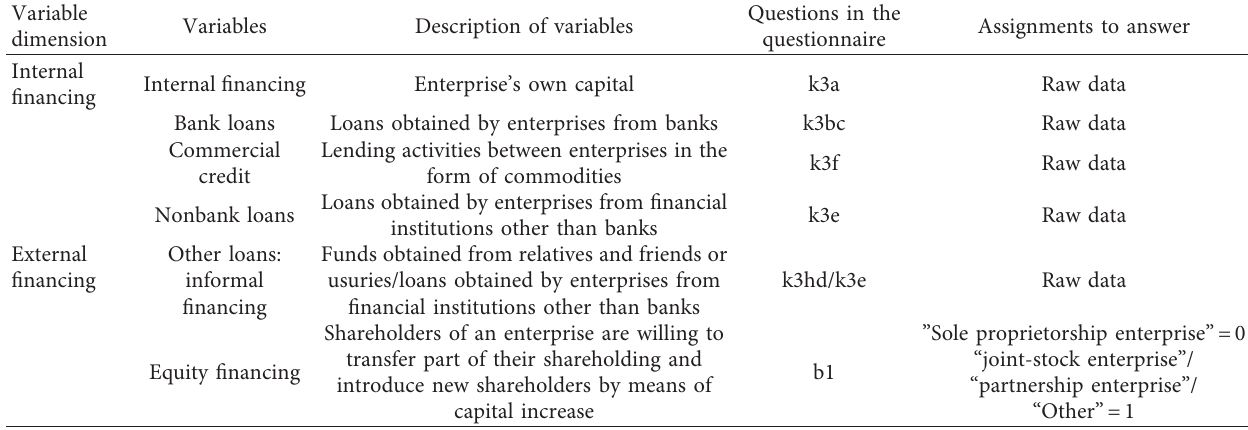
Table 3: Explanatory